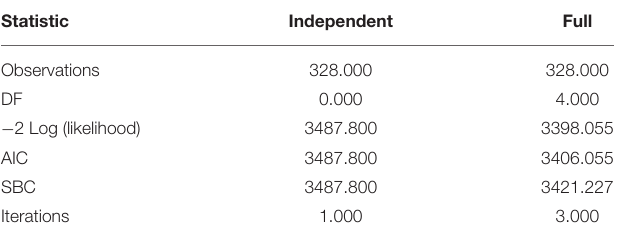
TABLE 7 | The goodness of fit statistic.